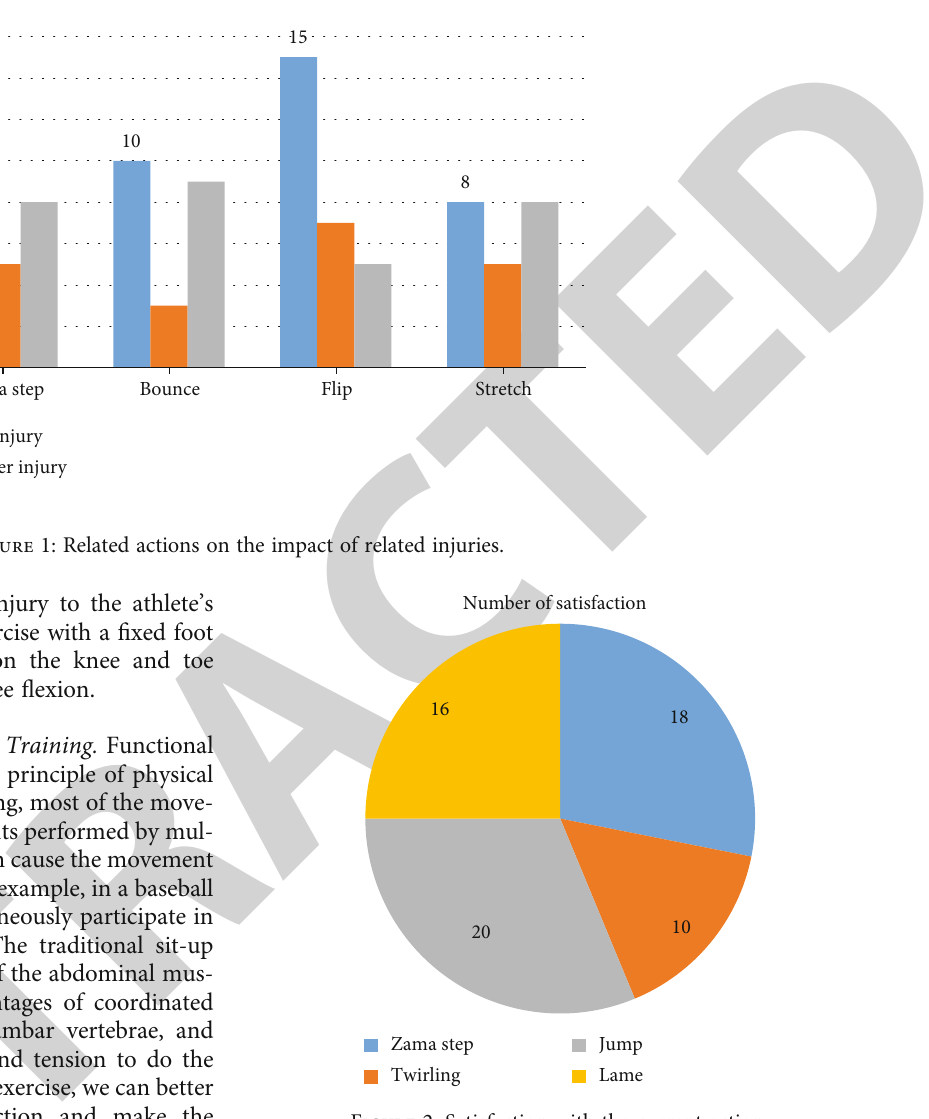
Figure 2: Satisfaction with the current